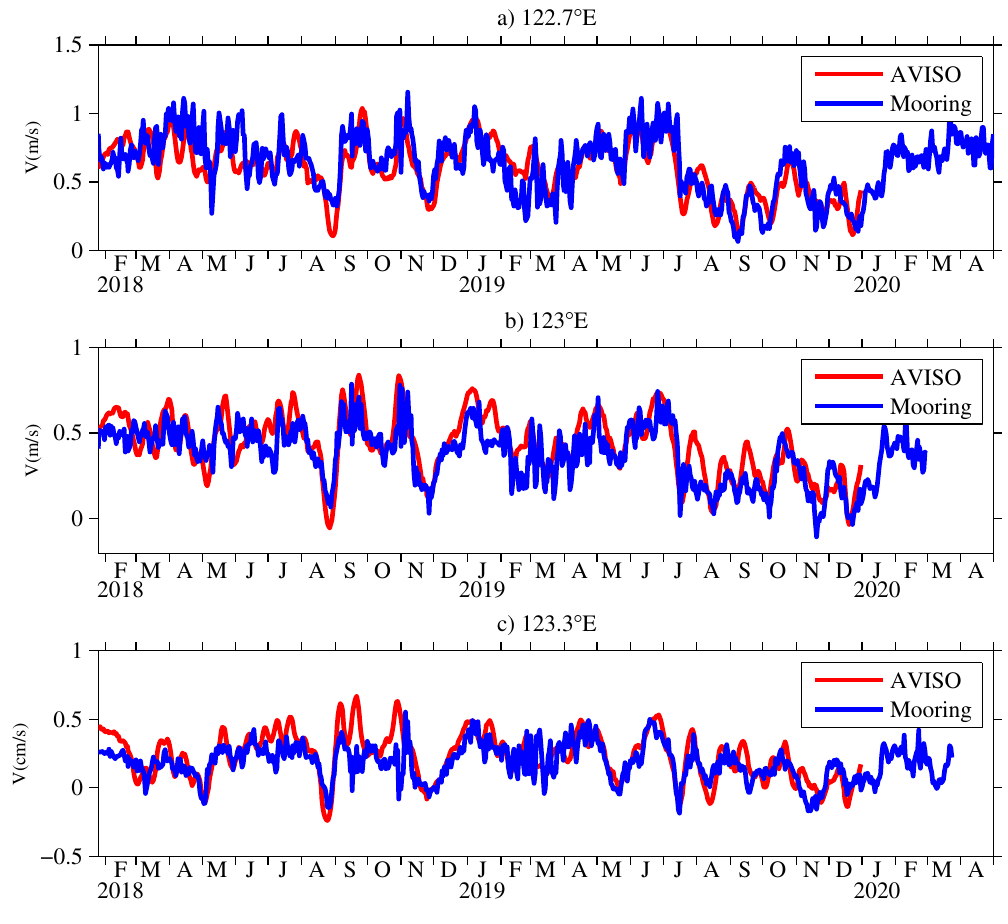
Figure 5. Observational meridional velocities (averaged over the upper 150 m) and the geostrophic currents from satellite data at ( a ) 122.7° E, ( b ) 123° E, and ( c ) 123.3° E along 18° N (units are m/s). The geostrophic currents are calculated from satellite altimetry (http:// www. marine. coper nicus. eu). Figures are plotted using MATLAB R2012b (http:// www. mathw orks.